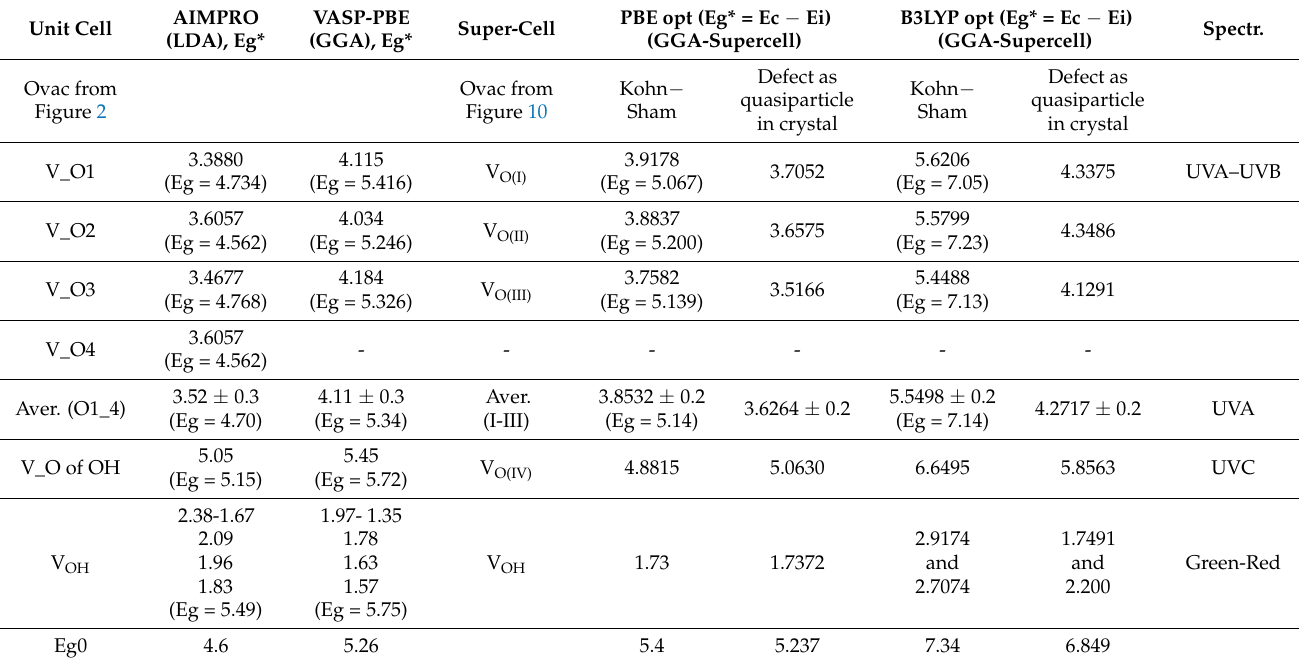
Table 6. HAP electronic properties with various vacancies Ovac {V O(I) , V O(II) , V O(III) from PO 4 , V O(IV) from OH} as well as V OH vacancy of OH group—in supercell model; for one unit cell model vacancies Ovac notation are the same as in Table